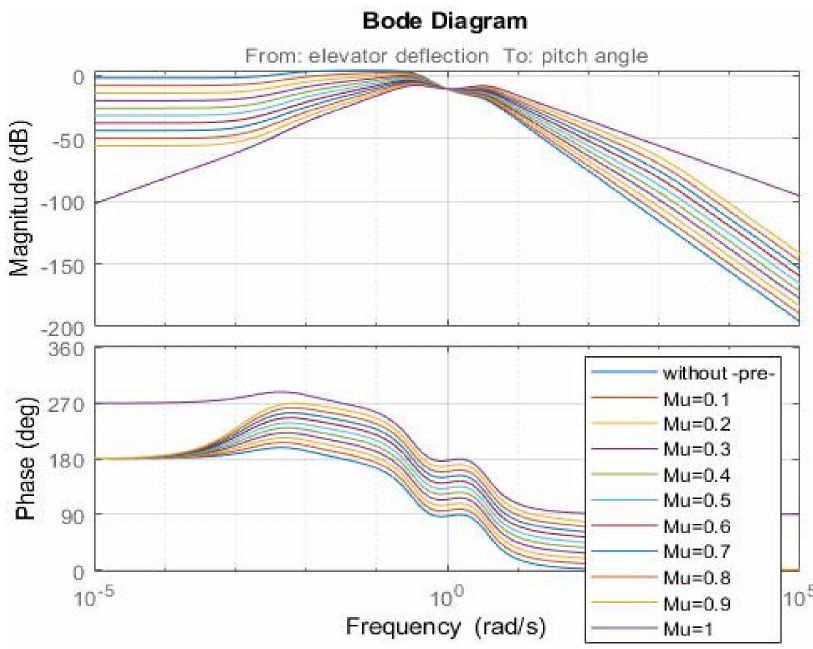
Figure 10. Open-loop Bode plots of the plant with and without FD compensator.